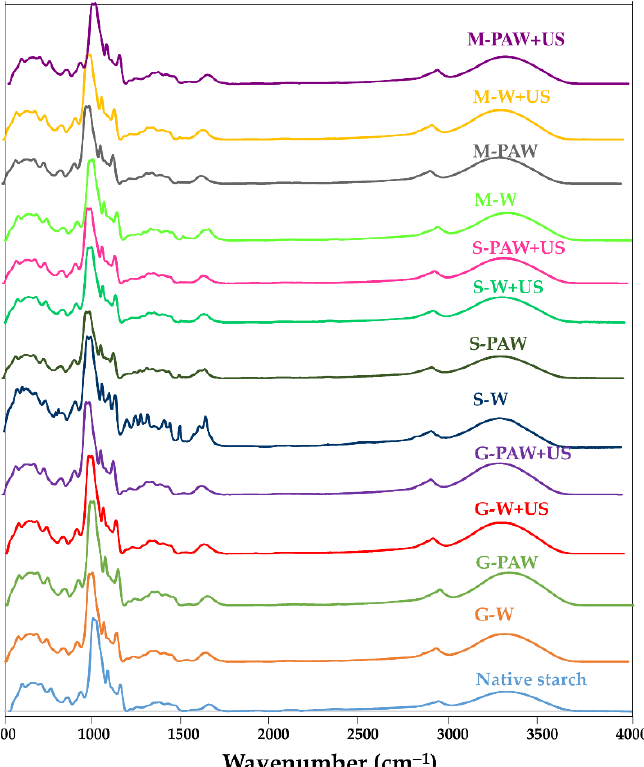
Figure 2. FTIR spectra of rice starch – phenolic complexes. Different phenolic compounds — gallic acid (G), sinapic acid (S), and crude Mon-pu ( Glochidion wallichianum Muell Arg) (M) extract — were complexed with hydrothermally pre-gelatinized rice starch prepared using distilled water (W) or plasma-activated water (PAW) without and with the aid of ultrasonication (+US). The native starch was used to